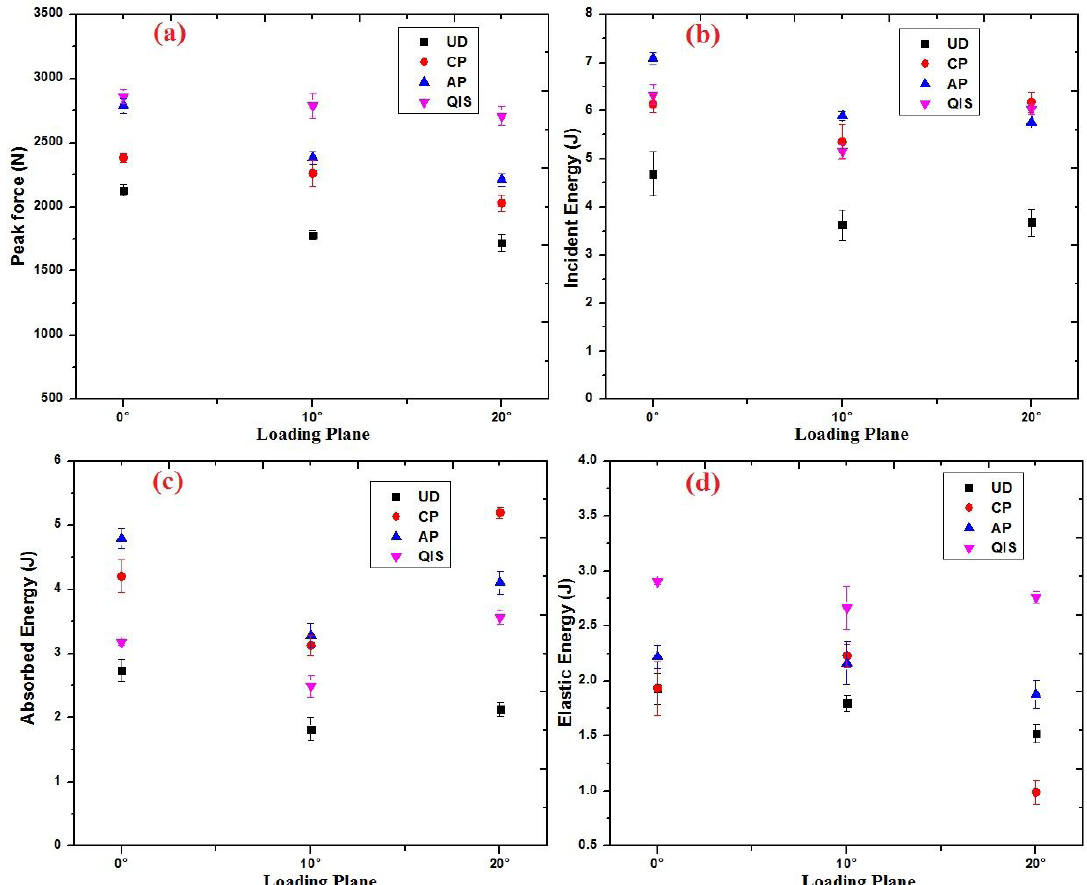
Figure 5. Effect of stacking sequence of glass/epoxy laminates on different loading planes (a) Peak force, (b) Incident Energy, (c) Absorbed Energy and (d) Elastic